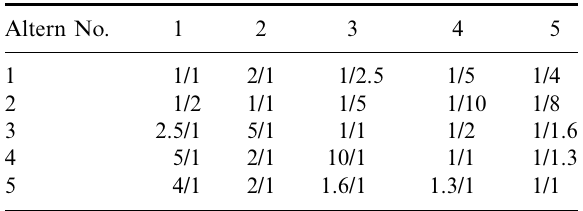
Table 2. Comparison of alternatives with respect to criteria Disturbance